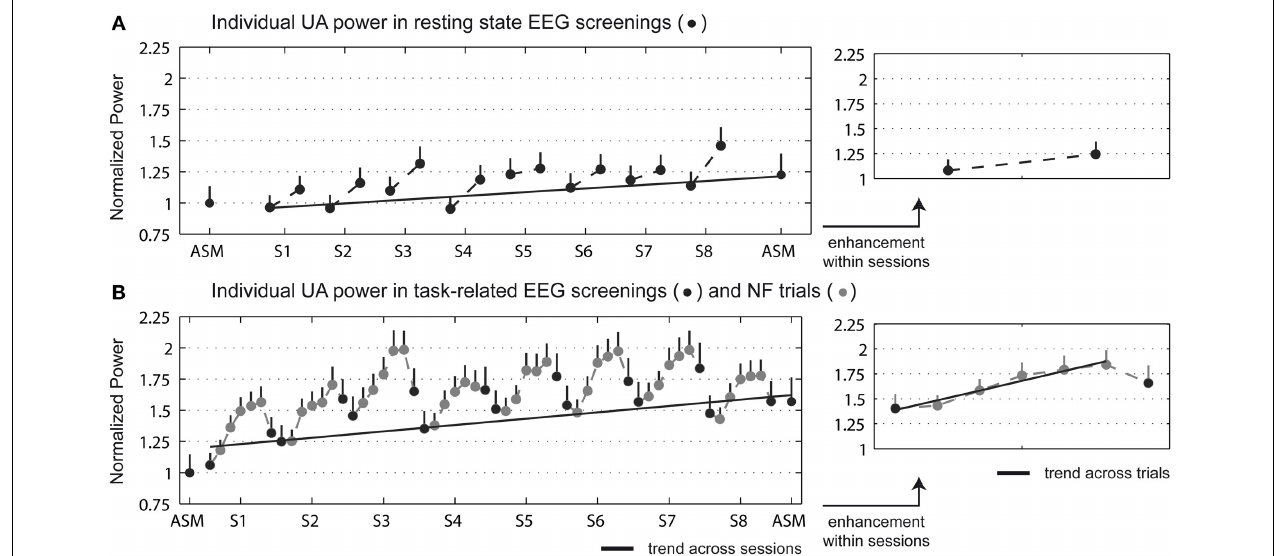
FIGURE 2 | Individual UA power (mean + s.e.m.) averaged across the feedback electrodes (P3, Pz, P4, O1, O2) for the NF group in the initial and final EEG screenings, and during the NF sessions. (A) Displays the resting state EEG screenings, and (B) the task-related EEG screenings and NF trials. Data was normalized to the